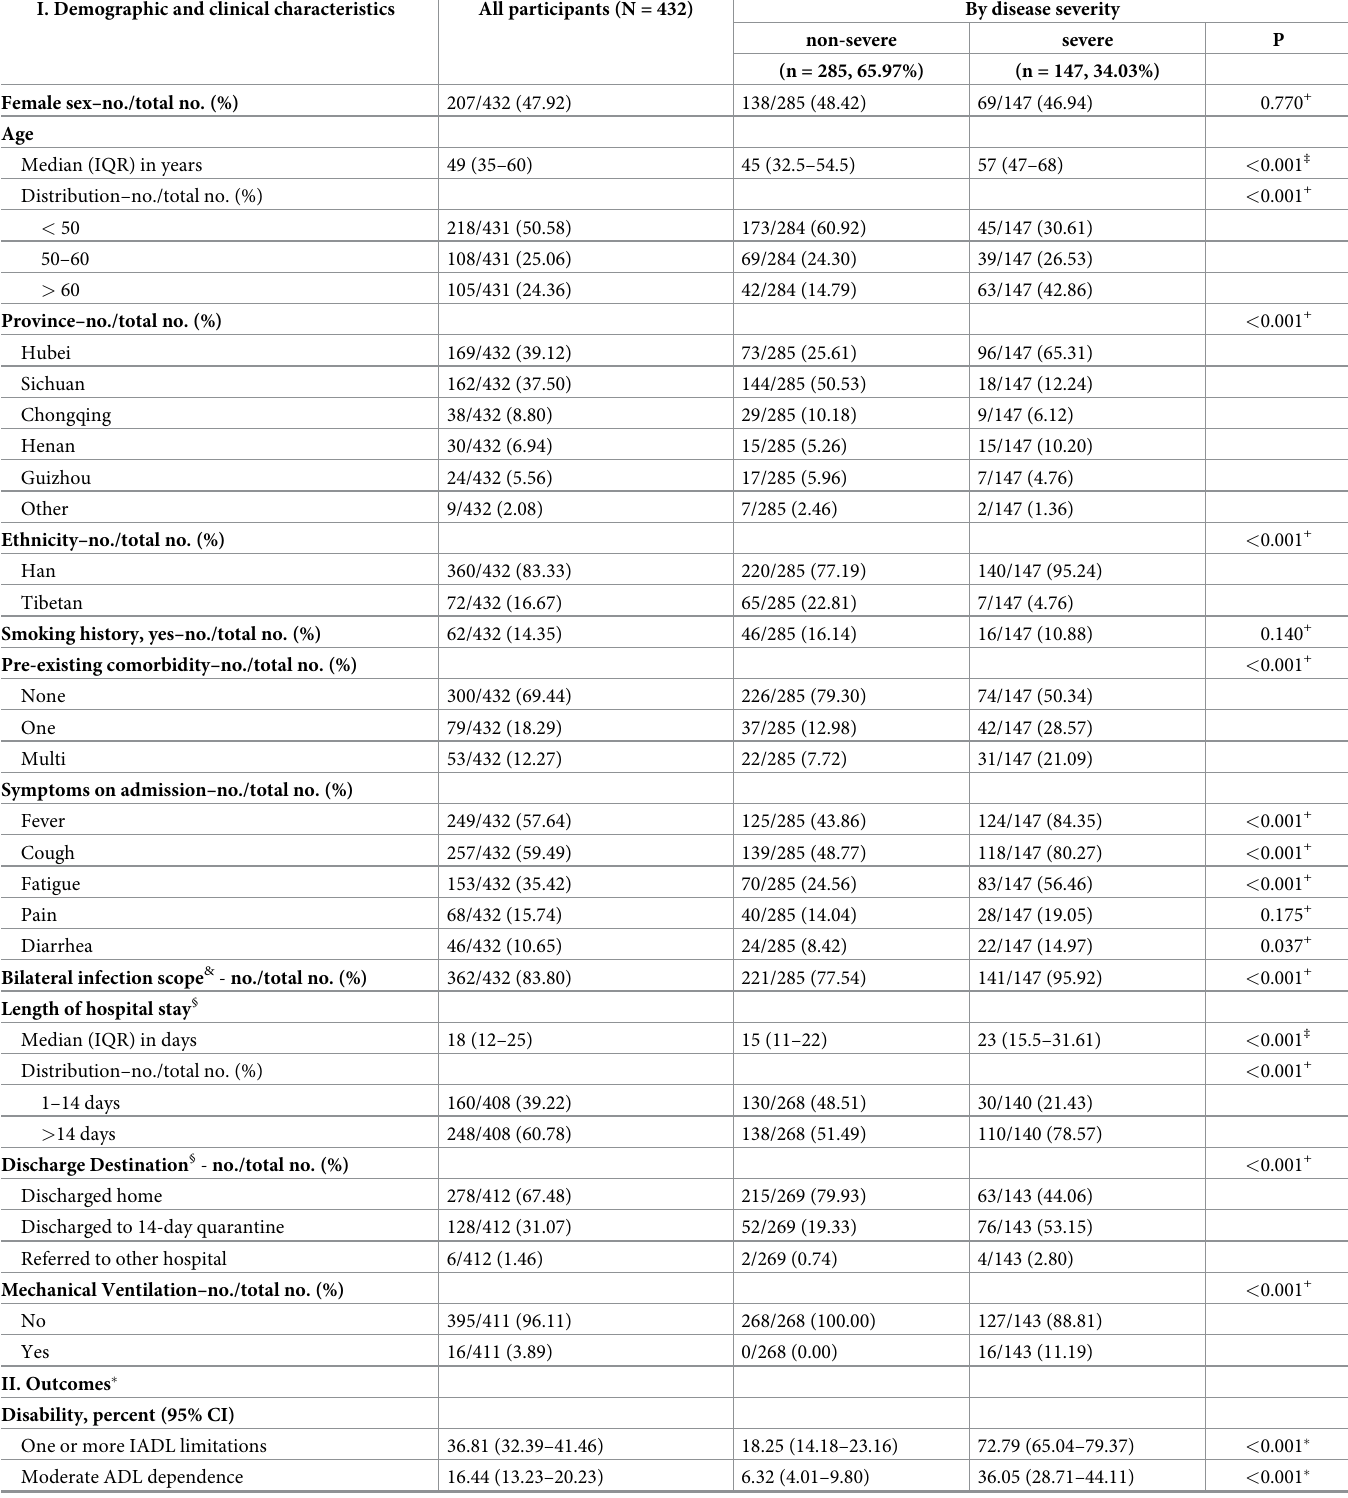
Table 1. Demographic and clinical characteristics of study participants (I) and prevalence of outcomes